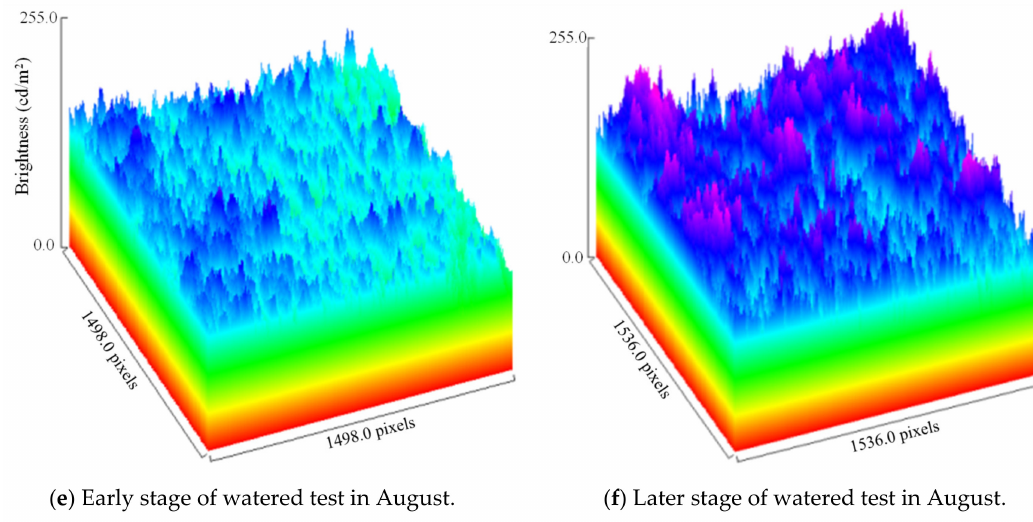
Figure 6. 3D surface plot of the visible images of watered quadrats.